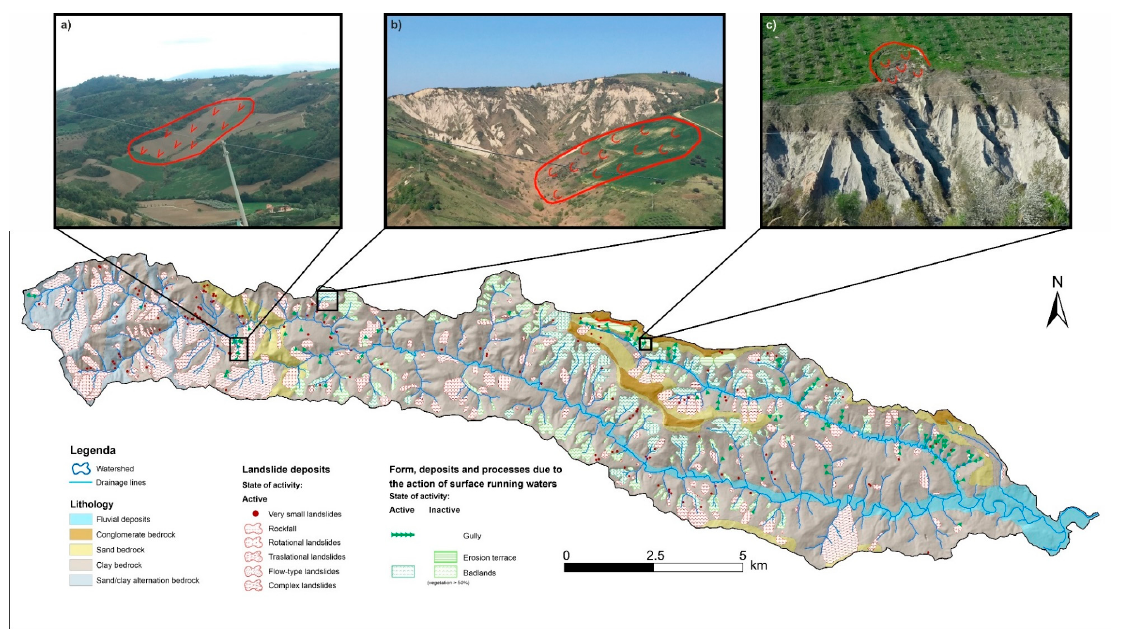
Figure 3. - Schematic Geomorphological map of Torrente Piomba catchment derived from a 1:10,000 field survey with some representative landforms: ( a ) rotational landslide; ( b ) flow type landslide on the side slope of a badland basin; ( c ) a very small landslide at the top of a badland.